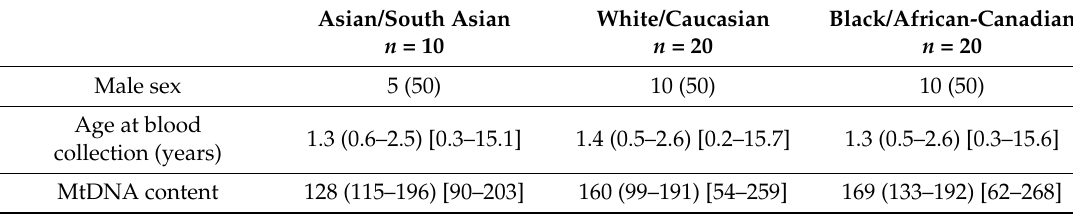
Table 4. Distributions of age, sex, and mtDNA content for three matched groups of HEUs without ASD used in a sensitivity analysis of possible relationship between mtDNA content and ethnicity.